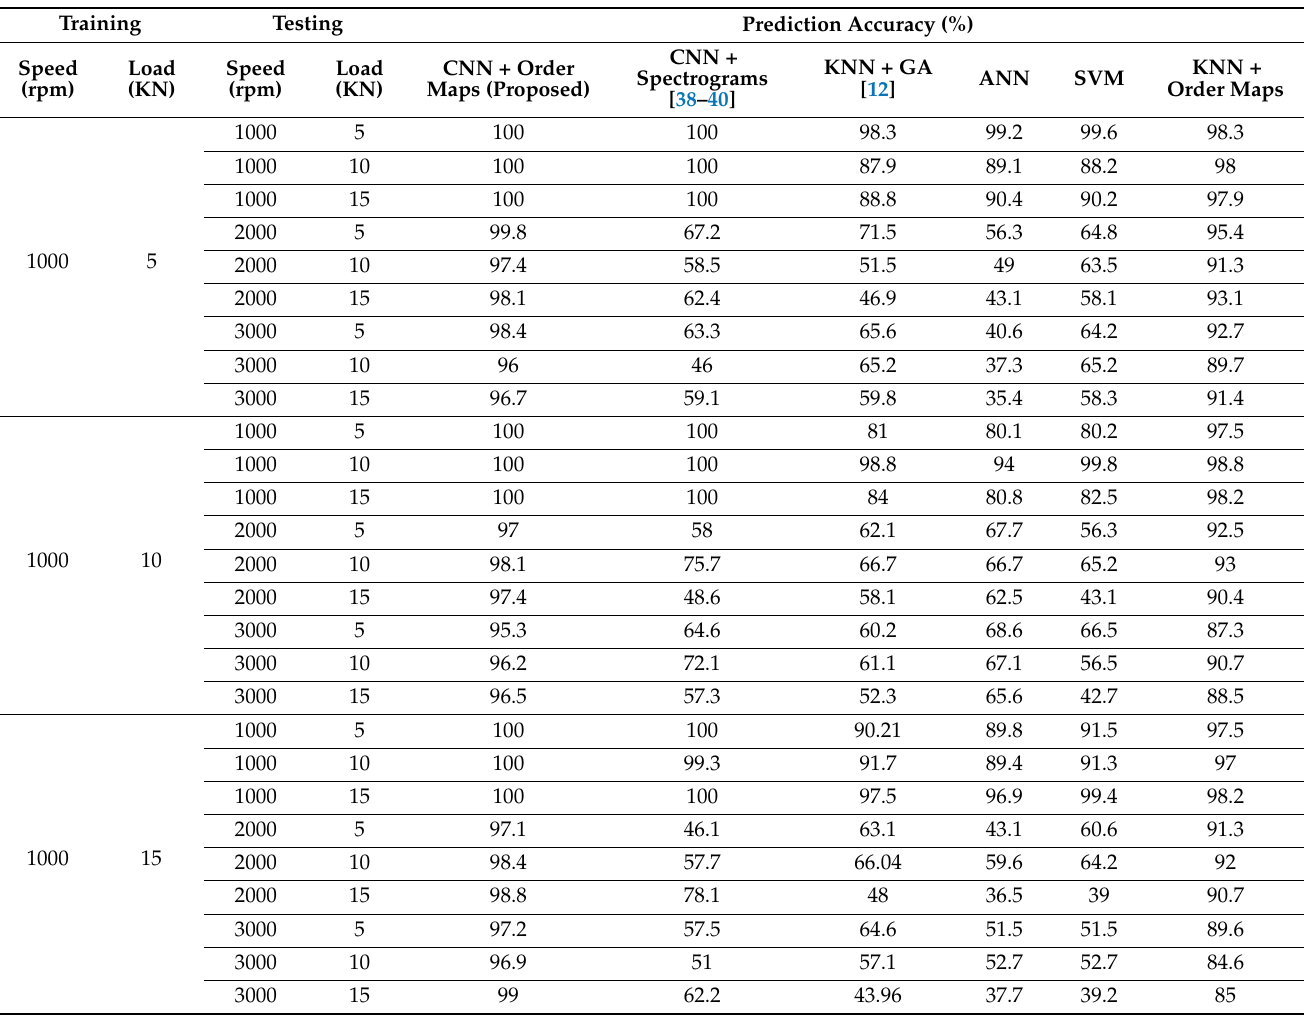
Table 5. Performance and comparison of the proposed methodology in terms of prediction accuracy for defect diagnosis under different operating conditions (case